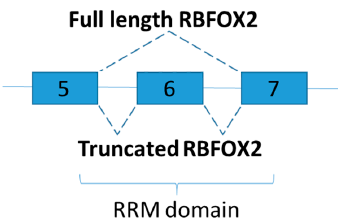
Figure 6. Schematic figure representing RBFOX2 splice variants in the diabetic hearts of mice. As part of RNA recognition motif (RRM) domain is removed, exclusion of exon 6 generates dominant negative version of RBFOX2.